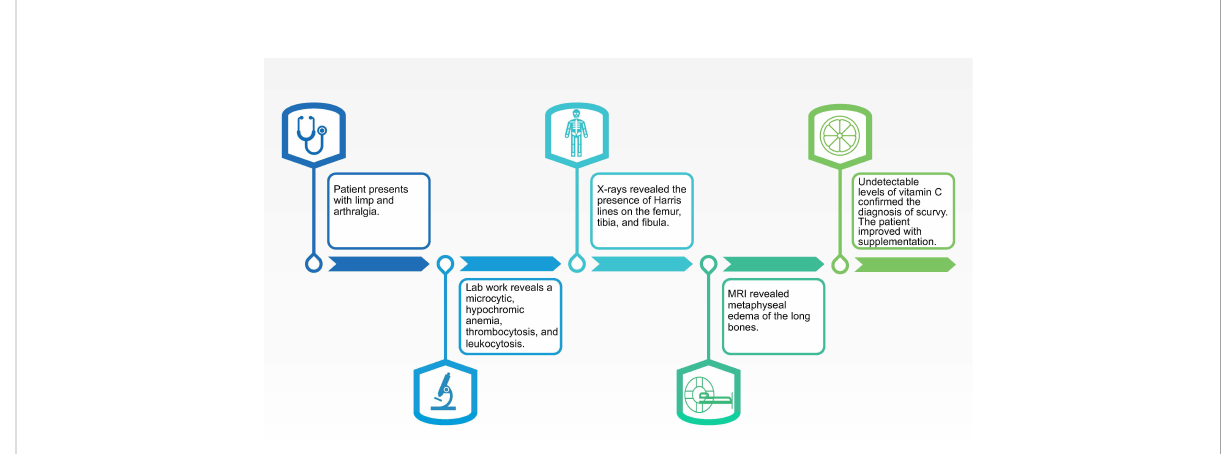
FIGURE 1 Timeline of relevant events in the patient